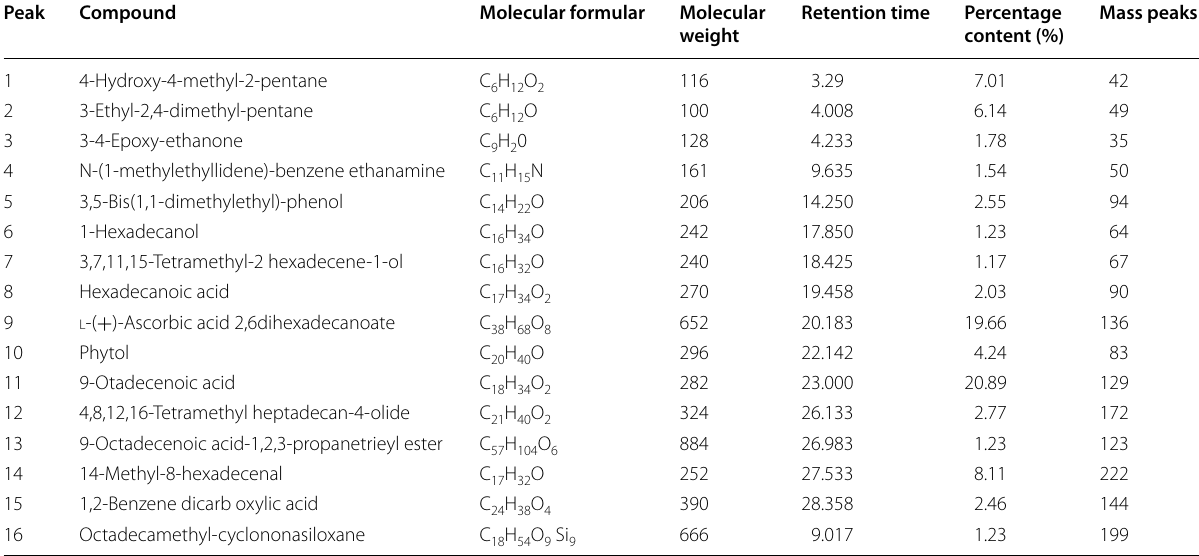
Table 6 Chemical composition of leaf essential oil from Moringa oleifera . Source : [64] Peak Compound Molecular formular Molecular